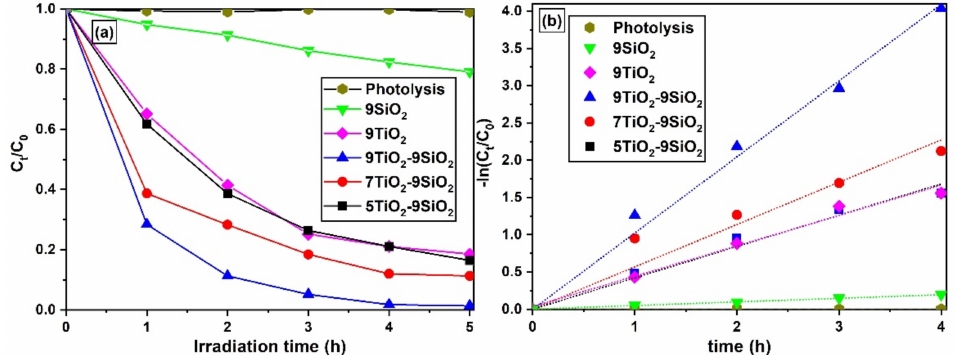
Figure 9. ( a ) Normalized concentration of MB vs UV-light irradiation time in the presence of TiO 2 -SiO 2 thin films. ( b ) Reaction kinetics of MB photocatalytic degradation at different loadings of TiO 2 -SiO 2